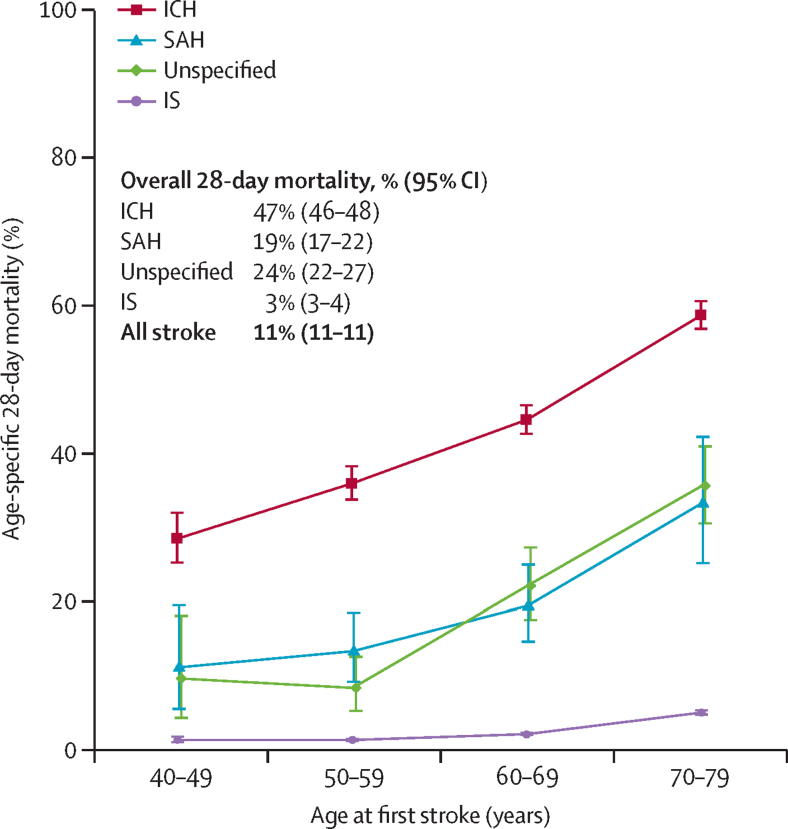
Age-specific 28-day mortality after a first stroke of different typesMortality was calculated as the proportion of participants dying from any cause within 28 days after a first stroke. Whiskers indicate 95% CIs. IS=ischaemic stroke. ICH=intracerebral haemorrhagic stroke. SAH=subarachnoid haemorrhage.